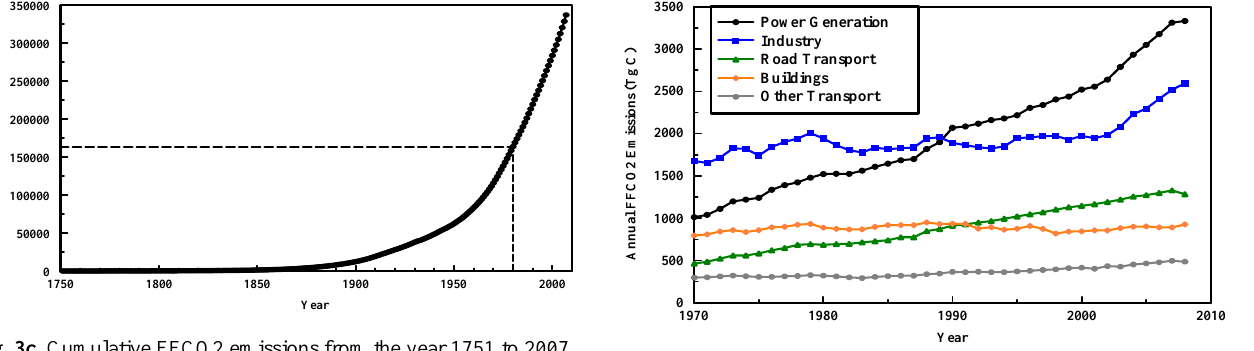
Fig. 3d. Sectoral FFCO2 emissions from the year 1970 to 2008. Data from EDGAR 4.2 (EC- JRC/PBL, 2011).